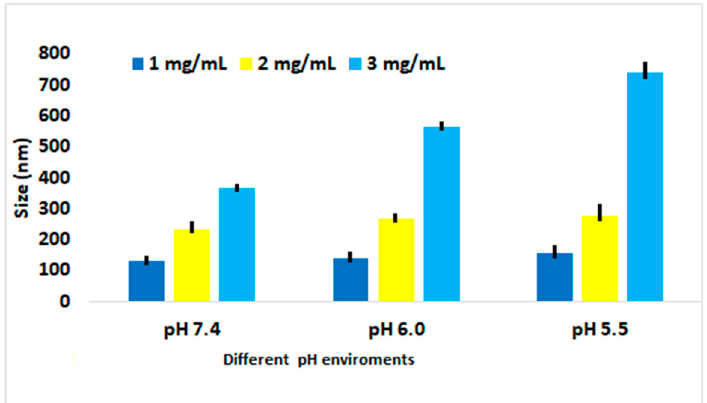
Figure 2. Preliminary, optimized characterization of quatsomes. E ff ect of the surfactant (StBAclm) concentration on the size of the quatsomes at di ff erent pH (n = 3 for all